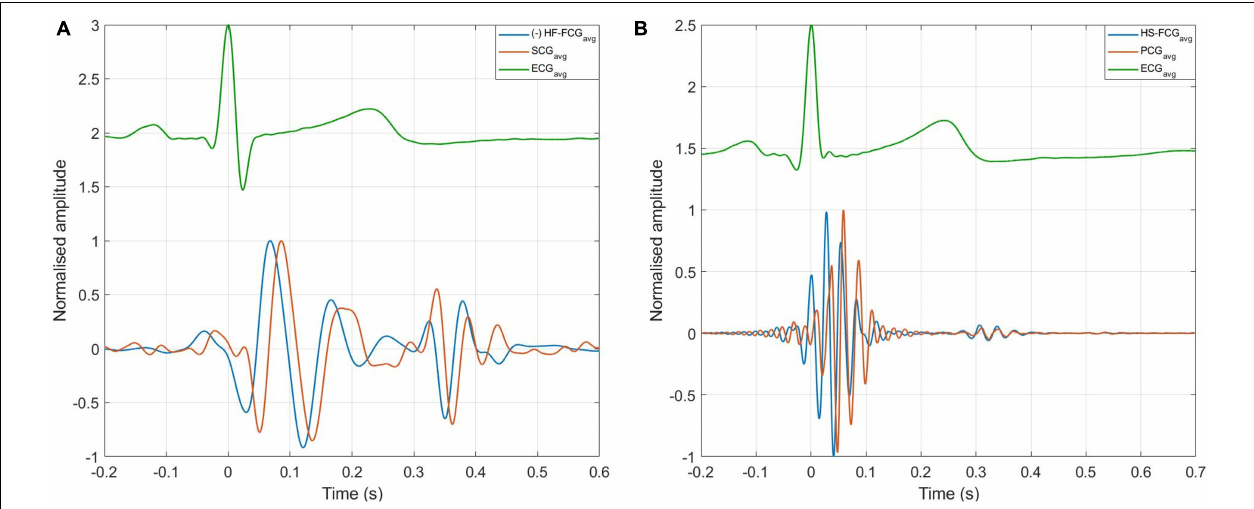
FIGURE 11 | ECG-triggered ensemble averages of FCG, SCG, and PCG. (A) Ensemble averages of HF-FCG and SCG; (B) ensemble averages of HS-FCG and PCG.